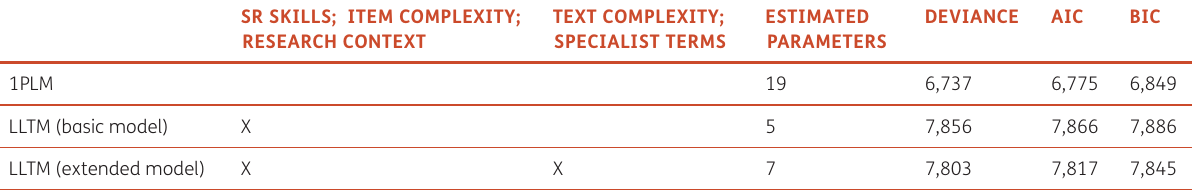
Table 2 Model-fit indices of the Rasch models specified in the present study. Note : The “X” marks which item features are included in the respective model for analysis. SR: scientific reasoning; AIC: Akaike information criterion; BIC: Bayesian information criterion; PLM: parameter logistic model; LLTM: linear logistic test